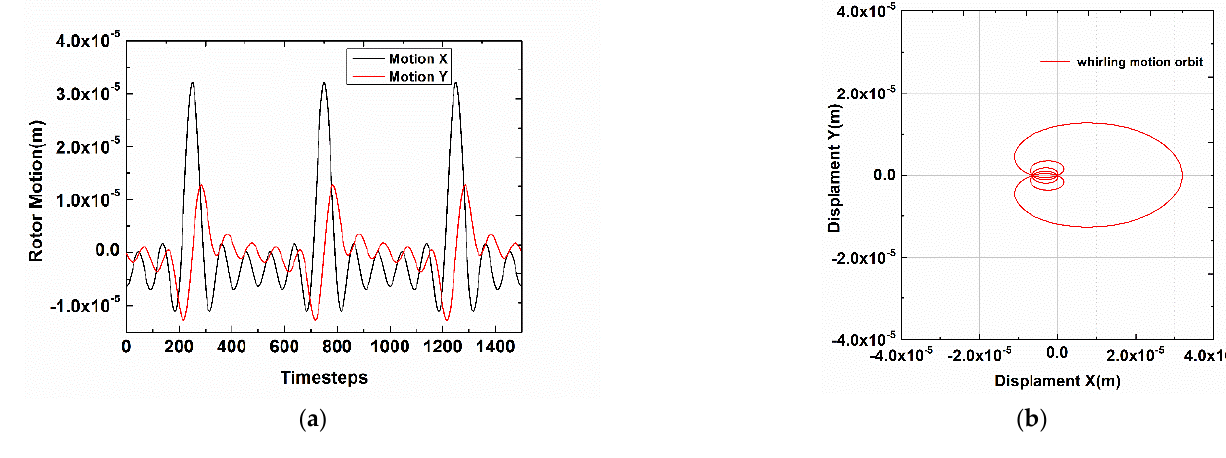
Figure 4. ( a ) Monitors of rotor motion ( x- direction excitation); ( b ) Displacement of multiple-frequency whirling orbit modal ( x- direction excitation).